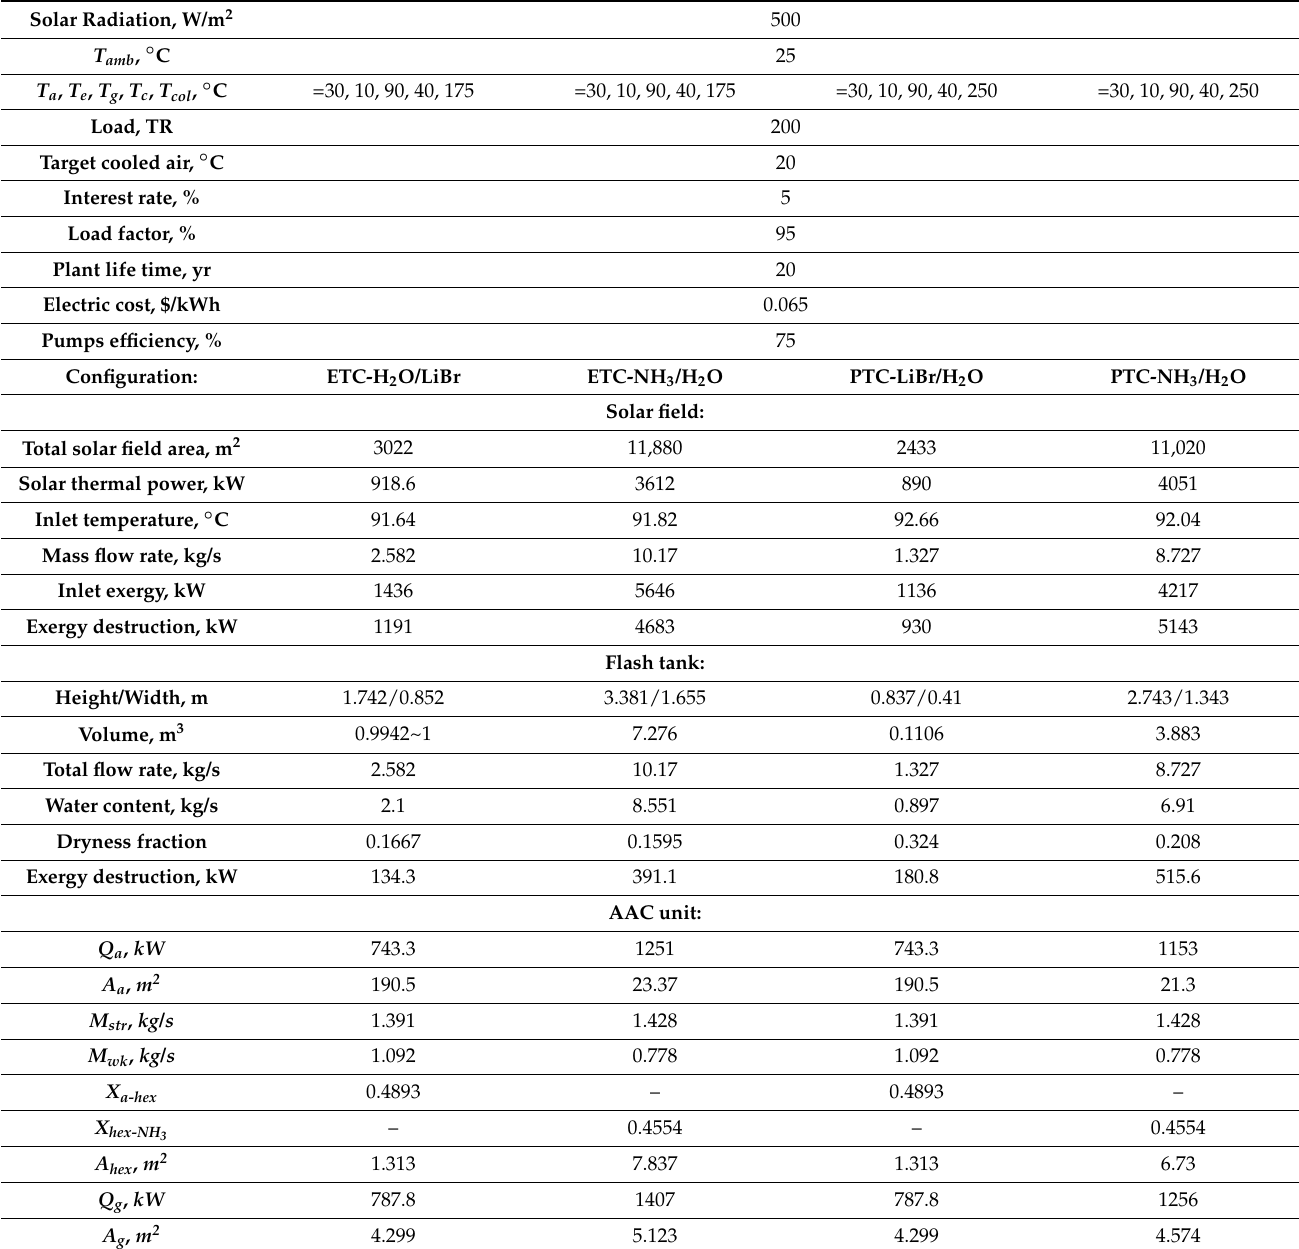
Table 2. Case study results @ 200 TR cooling